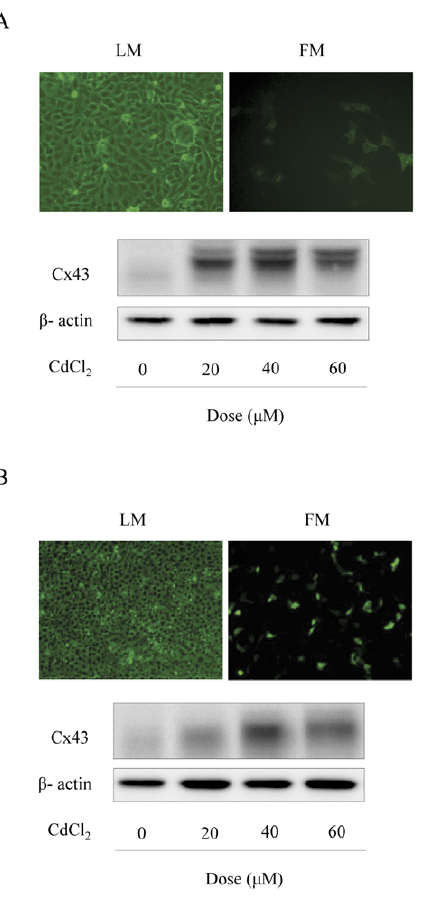
Figure 7. Effects of Cd 2 + on Cx43 expression in the mixed culture containing both Cx43-positive and Cx43-null LLC-PK1 cells. (A) Cx43-LLC-PK1 cells and LLC-PK1 cells were cultured in 1:4 proportions. The number and localization of Cx43-EGFP positive cells under fluorescent microscope in the mixed culture is shown (upper panel, images under light and fluorescent microscope, x200). The mixed culture was exposed to the indicated concentrations of CdCl 2 for 6 h. The cellular protein was extracted and subjected to Western blot analysis of Cx43 (lower panel). (B) LLC-PK1 cells were transiently transfected with a wild-type Cx43 gene or EGFP1 vector for 36 h. The number and distribution of EGFP-positive and negative cells under fluorescent microscope are shown and used for estimation of transfection efficiency by comparing with total cells under light microscope and fluorescent microscope (upper panel). The cells transiently transfected with a wild-type Cx43 gene were exposed to the indicated concentrations of CdCl 2 for 6 h. Cellular protein was subjected to Western blot analysis for Cx43 (lower panel). cells were isolated from each other with little possibility to form functional GJs (Fig. 7A, upper panel). Interestingly, Cd 2 + still stimulated Cx43 expression (Fig. 7A, lower panel). This result thus indicates that GJ is not a prerequisite for the Cx43-elevating effect of Cd 2 + .